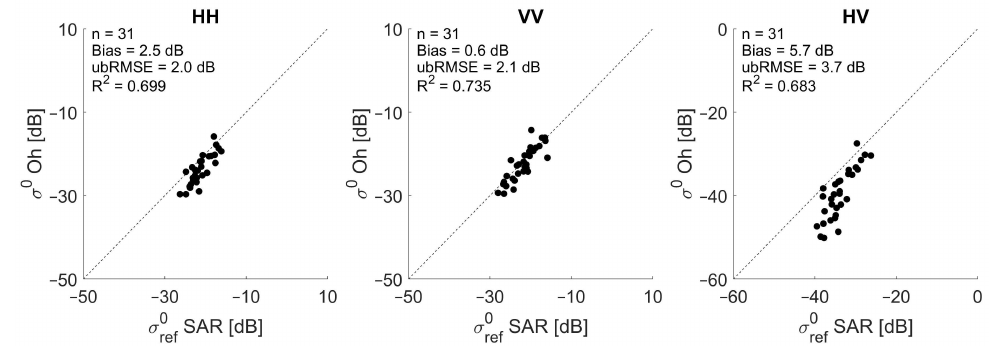
Figure 4. Simulated versus observed field average bare soil SAR backscatter for HH ( left ), VV ( middle ) and HV ( right ) polarization. Backscatter simulations are performed with the semi-empirical Oh model and in situ measured root-mean-square heights.